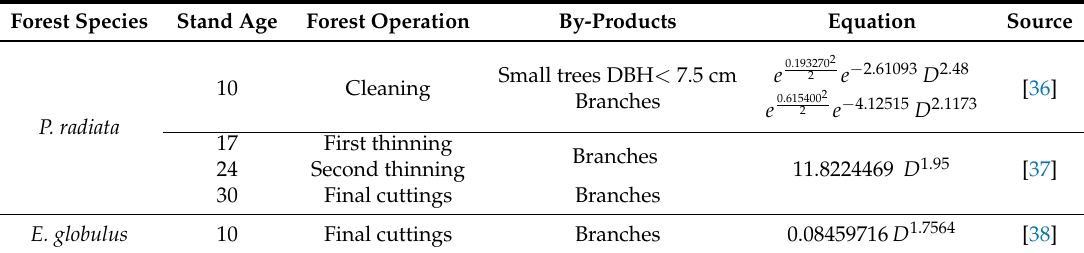
Table 2. Management regimens and main forestry by-products for P. radiata and E. globulus . DBH: diameter at breast